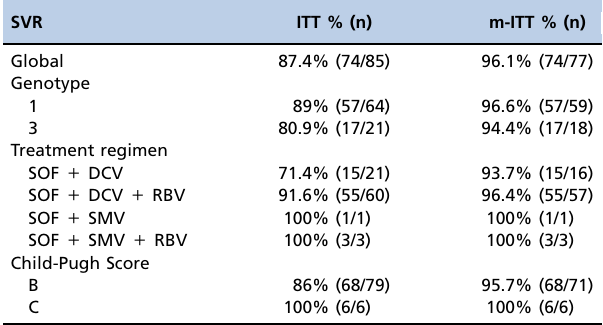
Table 2 - SVR rates according to therapeutic regimens, HCV genotypes and CP